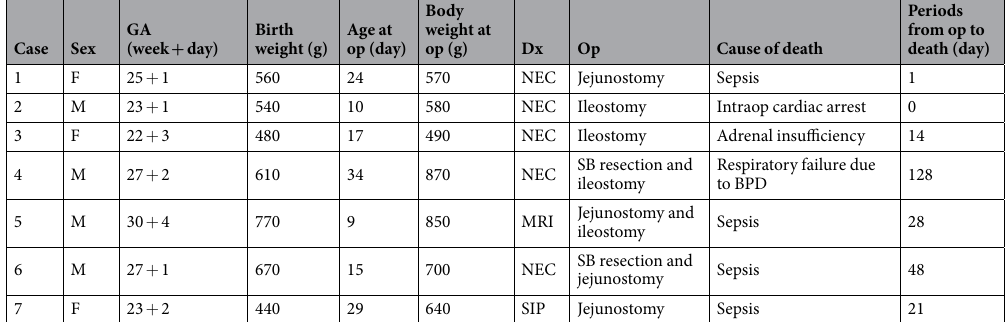
Table 1. Patients who underwent enterostomy and died before enterostomy closure. GA: Gestational age, Op: Operation, Dx: Diagnosis, F: Female, M: Male, NEC: Necrotizing enterocolitis, MRI: Meconium related ileus, SIP: Spontaneous intestinal perforation, BPD: Bronchopulmonary